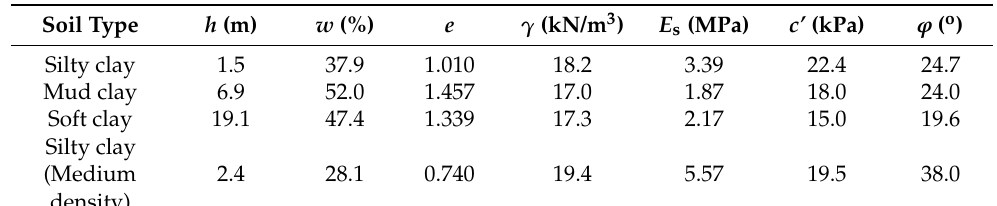
Table 1. Index properties of the subsoil.